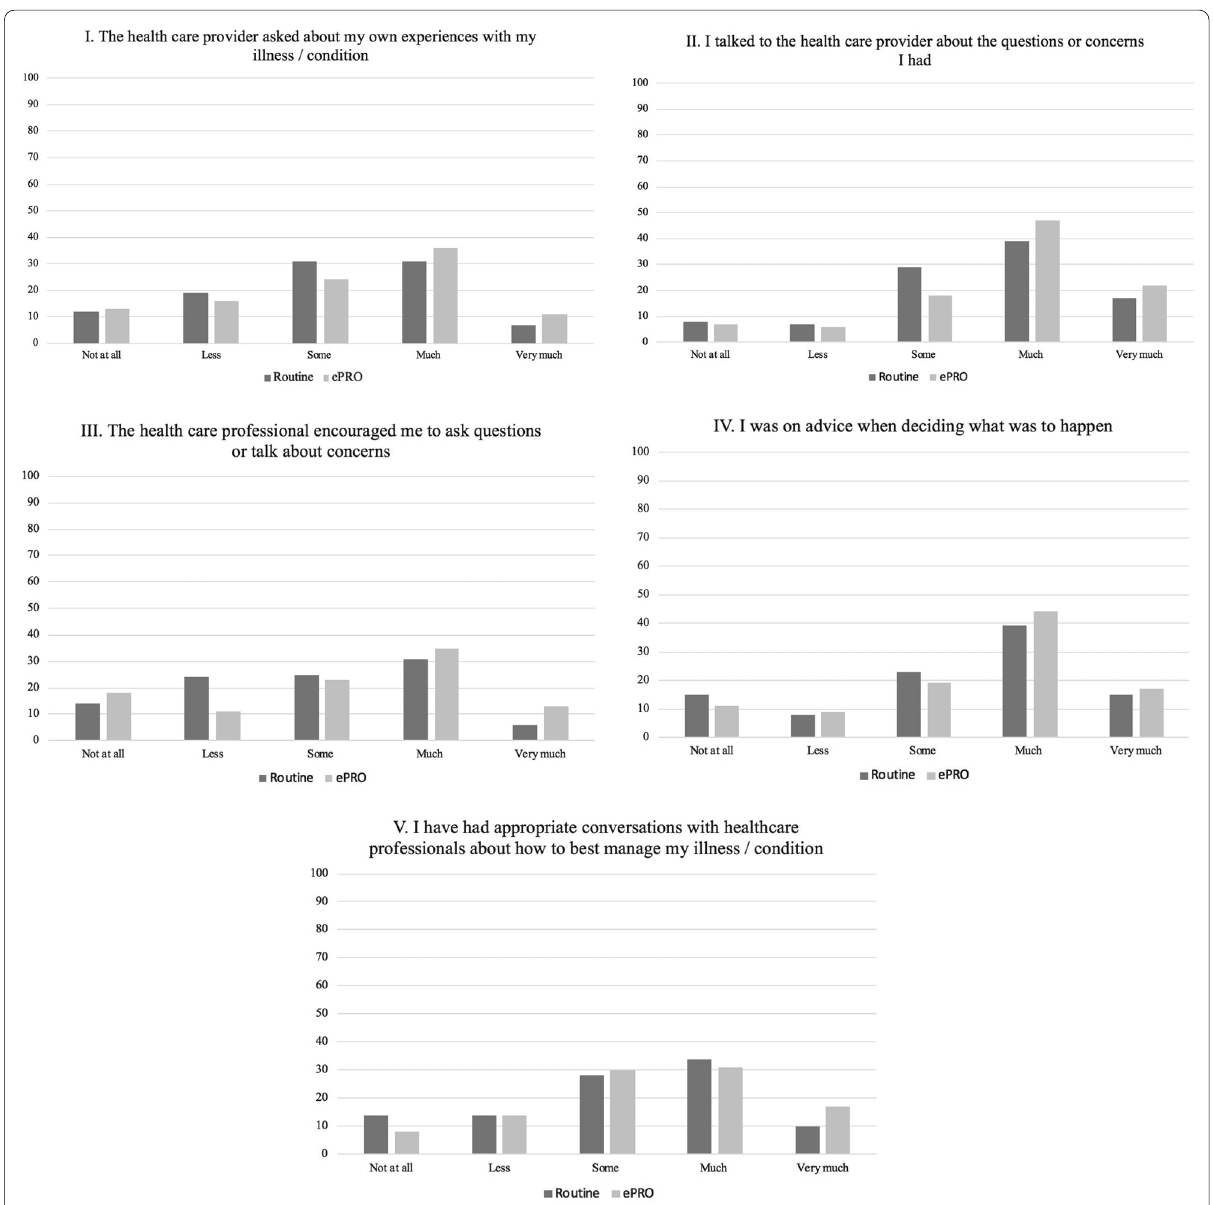
Fig. 5 Patient’s assessment of patient involvement in the follow-up consultation stratified by